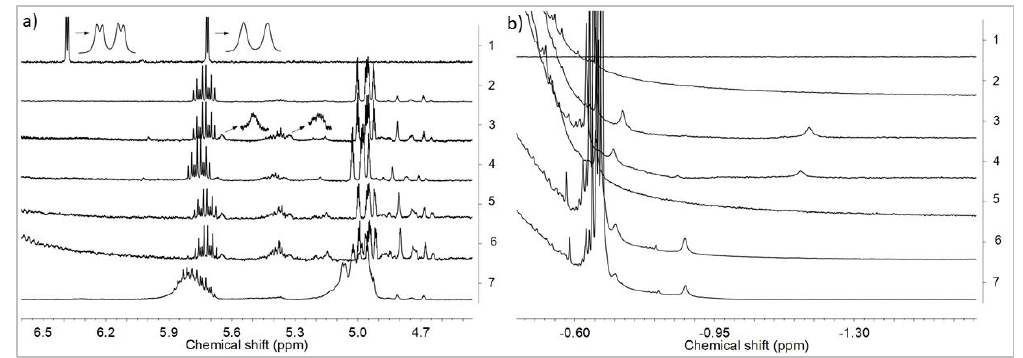
Figure 4. 1 H NMR spectra in two different ranges ( a , b ) in toluene-d8 at 20 °C of rac -Et(Ind) 2 ZrCl 2 (1), MMAO (2), rac -Et(Ind) 2 ZrCl 2 /MMAO: Al/Zr = 50 (3), Al/Zr=100 (4), Al/Zr = 500 (5), Al/Zr = 1000 (6)